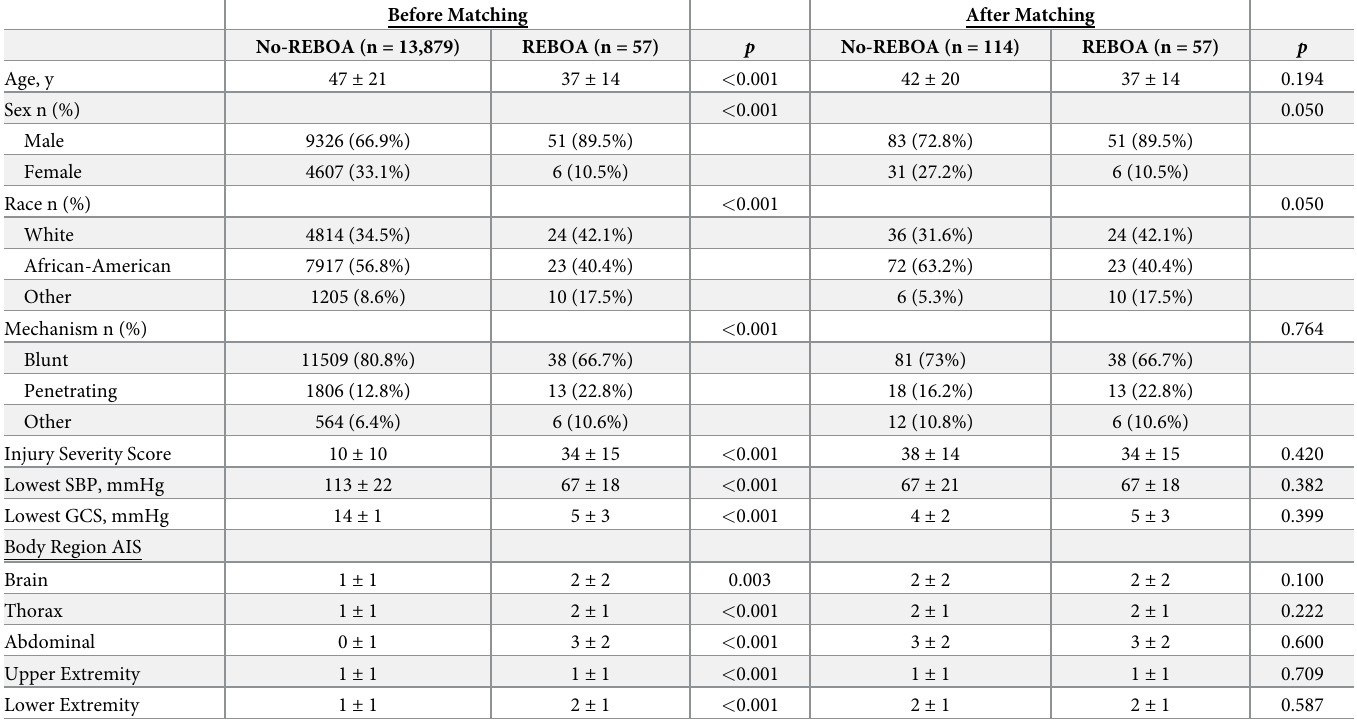
Table 1. REBOA to No-REBOA contemporary group before and after propensity-matching � . Before Matching After